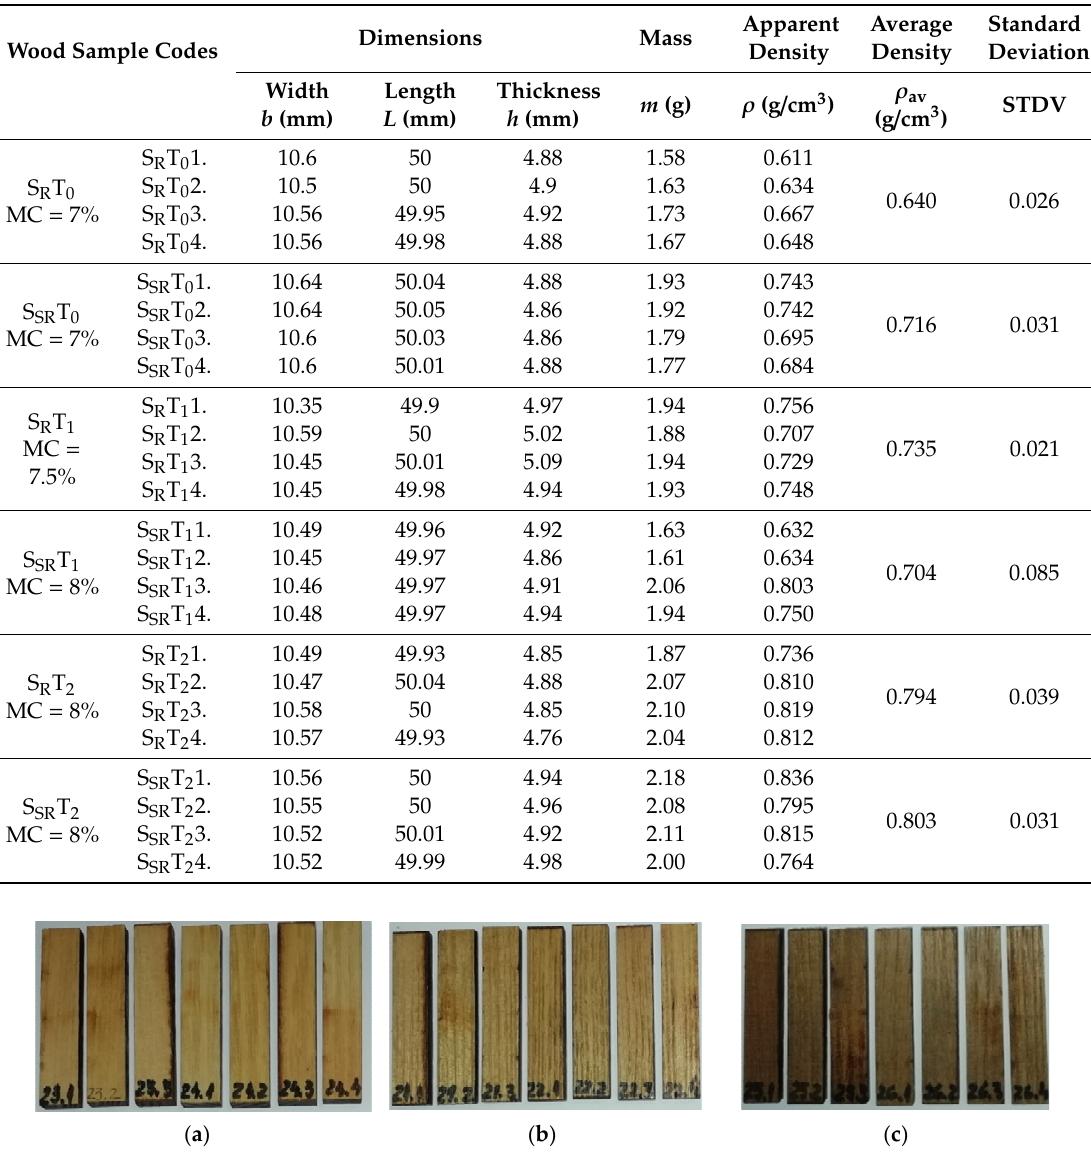
Figure 1. The wood samples: ( a ) Control sample (without treatment); ( b )T1-samples subjected to 1 st treatment (5% ammonium hydroxide); ( c ) T2-samples subjected to 2 nd treatment (10% ammonium hydroxide).